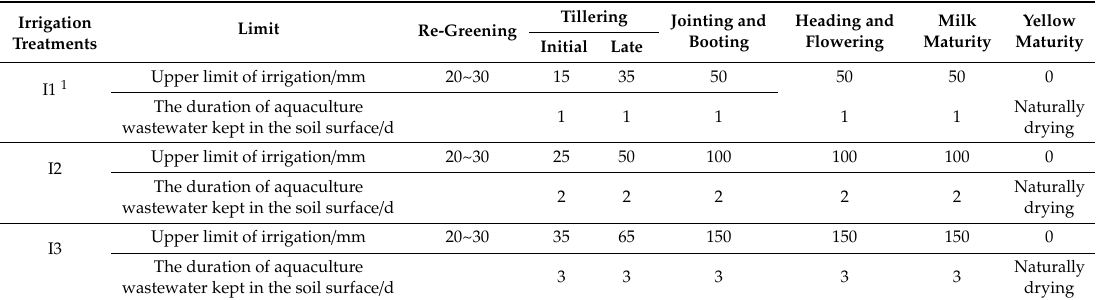
Table 1. Water table depth control and the duration of flooding in di ff erent stages for three irrigation treatments.